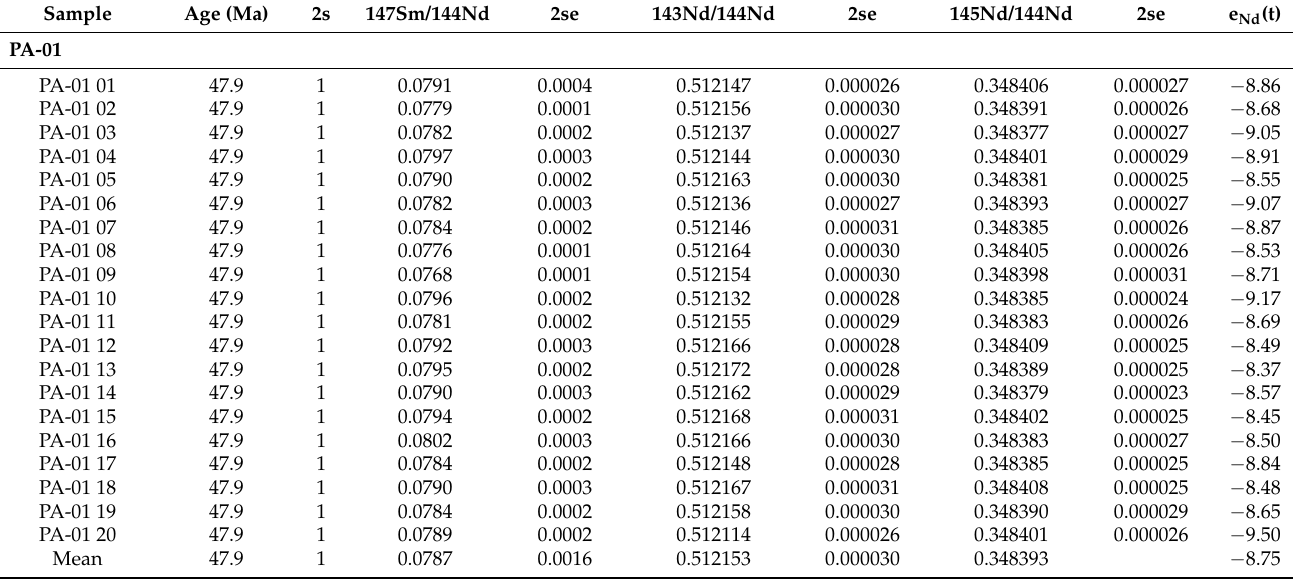
Figure 4. Mean In situ Th–Pb ages obtained by LA-ICP-MS for parisite samples PA-01 ( A ), PA-02 ( B ), PA-03 ( C ) and PA-04 ( D ). Table 4. 147Sm/144Nd, 143Nd/144Nd and 145Nd/144Nd data.